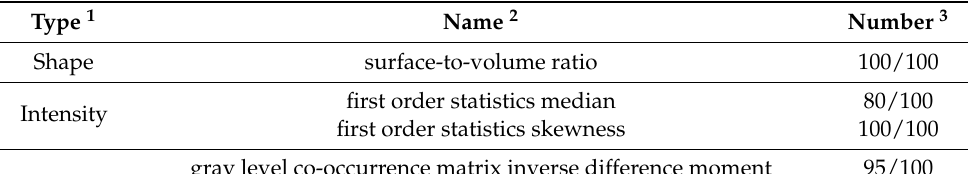
Table 2. The 10 most frequently selected features by the EFS-algorithm SDA50GA10_HAFF_BACC after 100 repetitions for classification of LNs labeled “pathologic with